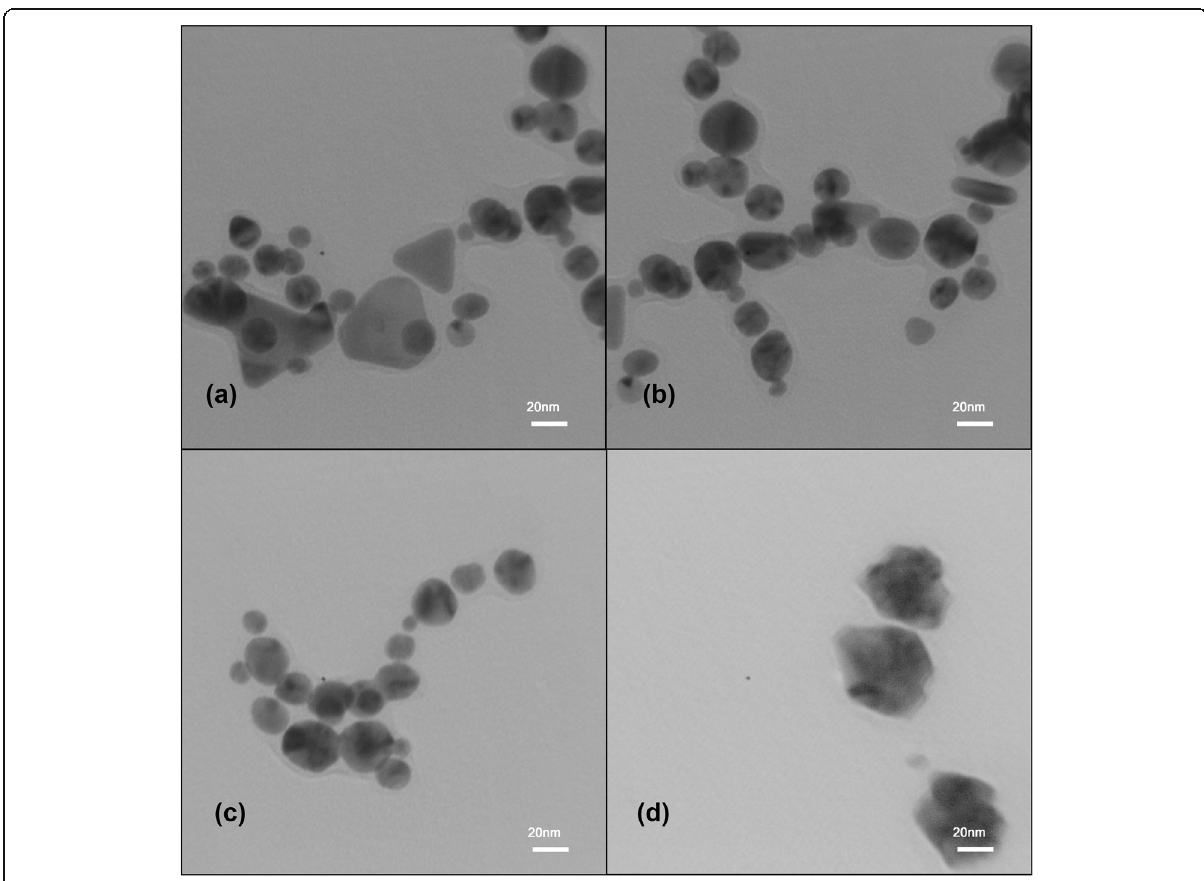
Fig. 4 TEM images of the synthesized AuNPs using different amounts of jujube extract [( a )1, ( b )2, ( c )4 and ( d )10 mL]